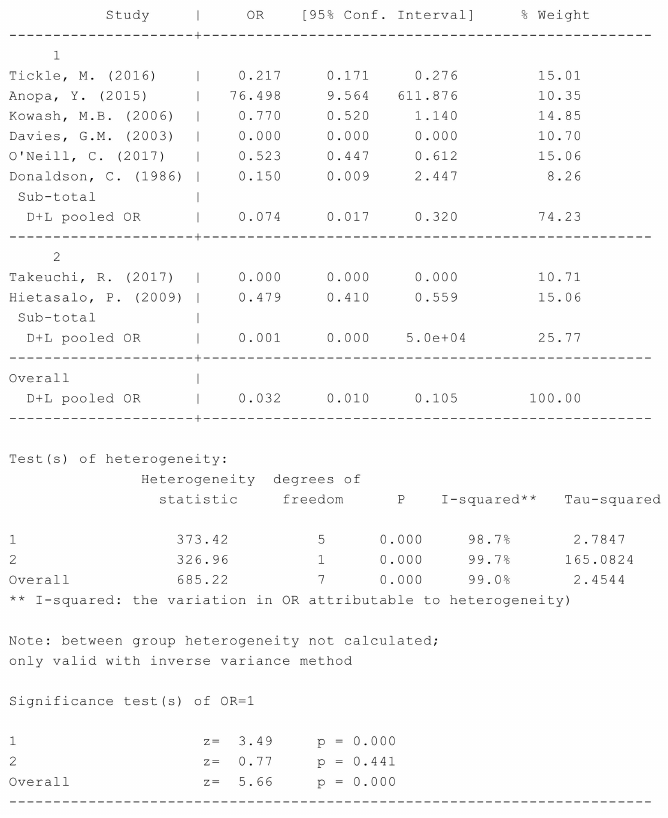
Figure A4. STATA do-file for analysis Figure 5. “metan DMFTintervention Costintervetion DMFTcontrol Costcontrol, label (namevar = Author, yearvar = year) by (age) random or”